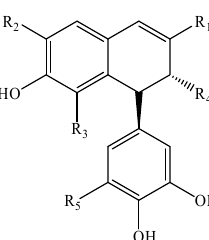
Figure 19. Isolated nor -lignans in the plant kingdom—part 18.